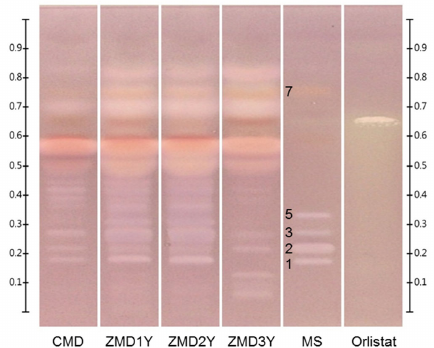
Figure 5. Typical HPTLC bioautograms of lipase inhibition assays. Plates were viewed under white light. CMD: one ‐ year ‐ old CMD, ZMD 1Y: one ‐ year ‐ old ZMD, ZMD2Y: two ‐ year ‐ old ZMD, ZMD3Y: three ‐ year ‐ old ZMD, MS: mixed standards. 1. ophiopogonin D (R f 0.18), 2. ophiopojaponin C (R f 0.23), 3. ophiopogonin D’ (R f 0.28), 5. ophiopogonin C’ (R f 0.34), 7. methylophiopogonanone B (R f 0.78), Orlistat: positive control.